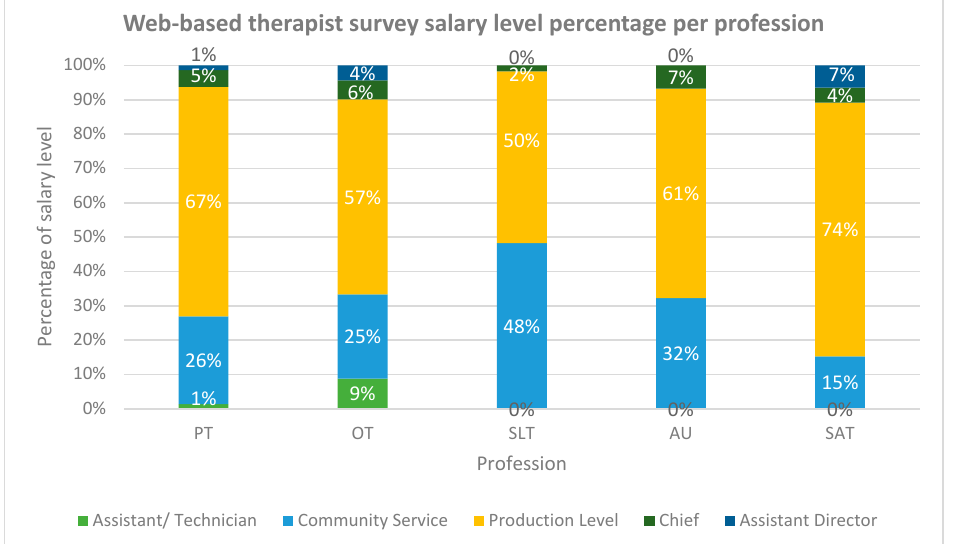
Figure 2. Percentages of rehabilitation therapists (all types combined) within different salary levels across the three provinces.